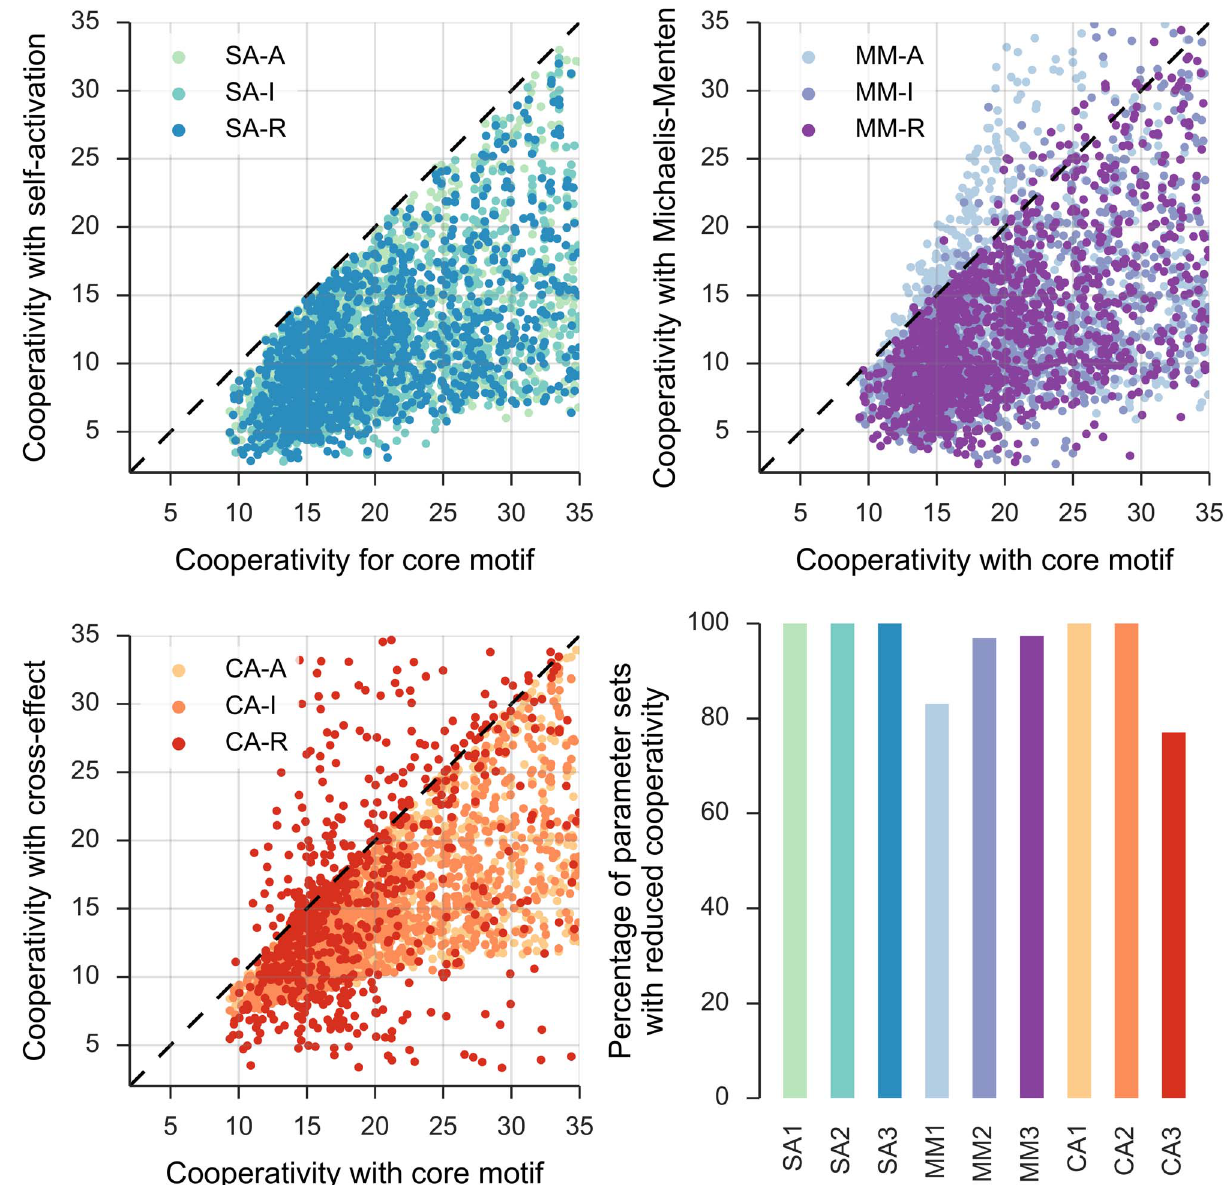
Figure 2. Minimum cooperativity required for oscillations for the core motif versus the positive feedback motifs. The motifs with positive feedback are grouped according to the type of mechanism: self-activation (SA), Michaelis-Menten (MM) degradation or cross-activation (CA). The component (activator, intermediate or repressor) on which the positive feedback is acting is also indicated by color. Each point represents one choice of parameters for the motif and the comparison is made with common parameters having identical values. In the scatter plots, points below the y=x line represent cases where the positive feedback motif oscillates at a smaller cooperativity than the core motif. The data in the three scatter plots is summarized in the bar graph, i.e., the percentage of parameter sets where positive feedback motifs oscillate with smaller cooperativity than the core motif.